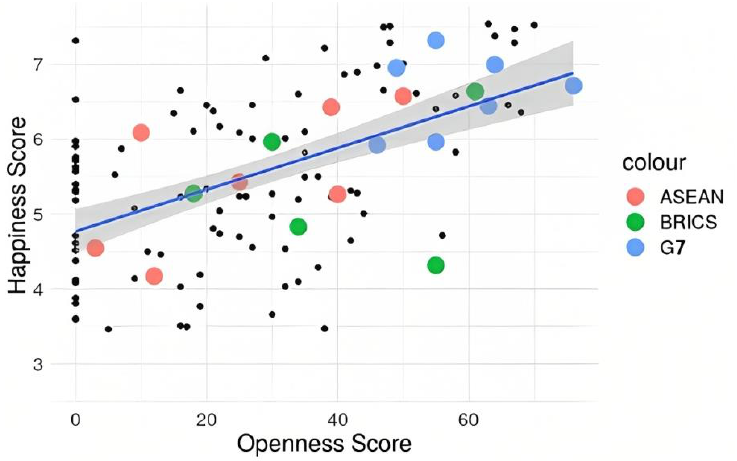
Figure 7. Clustering for the correlation between openness and happiness in the ASEAN, BRIC, and G7 countries.